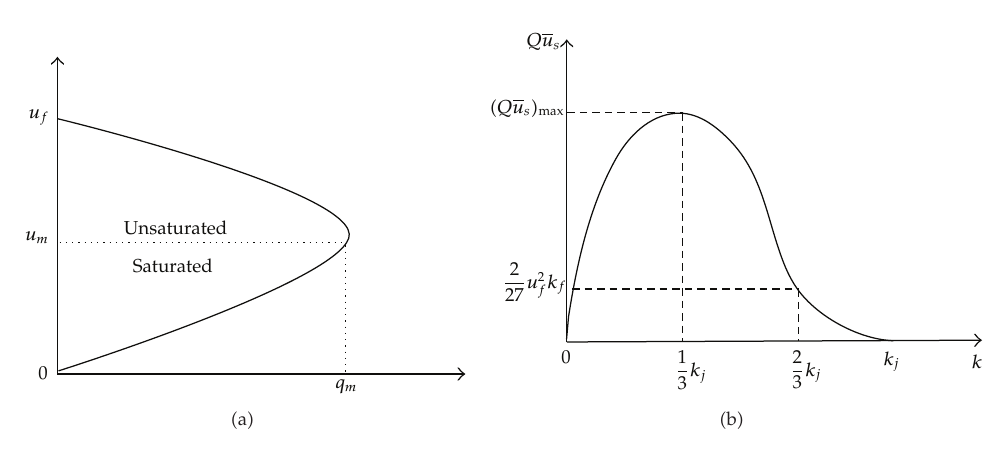
Figure 3: The speed-volume